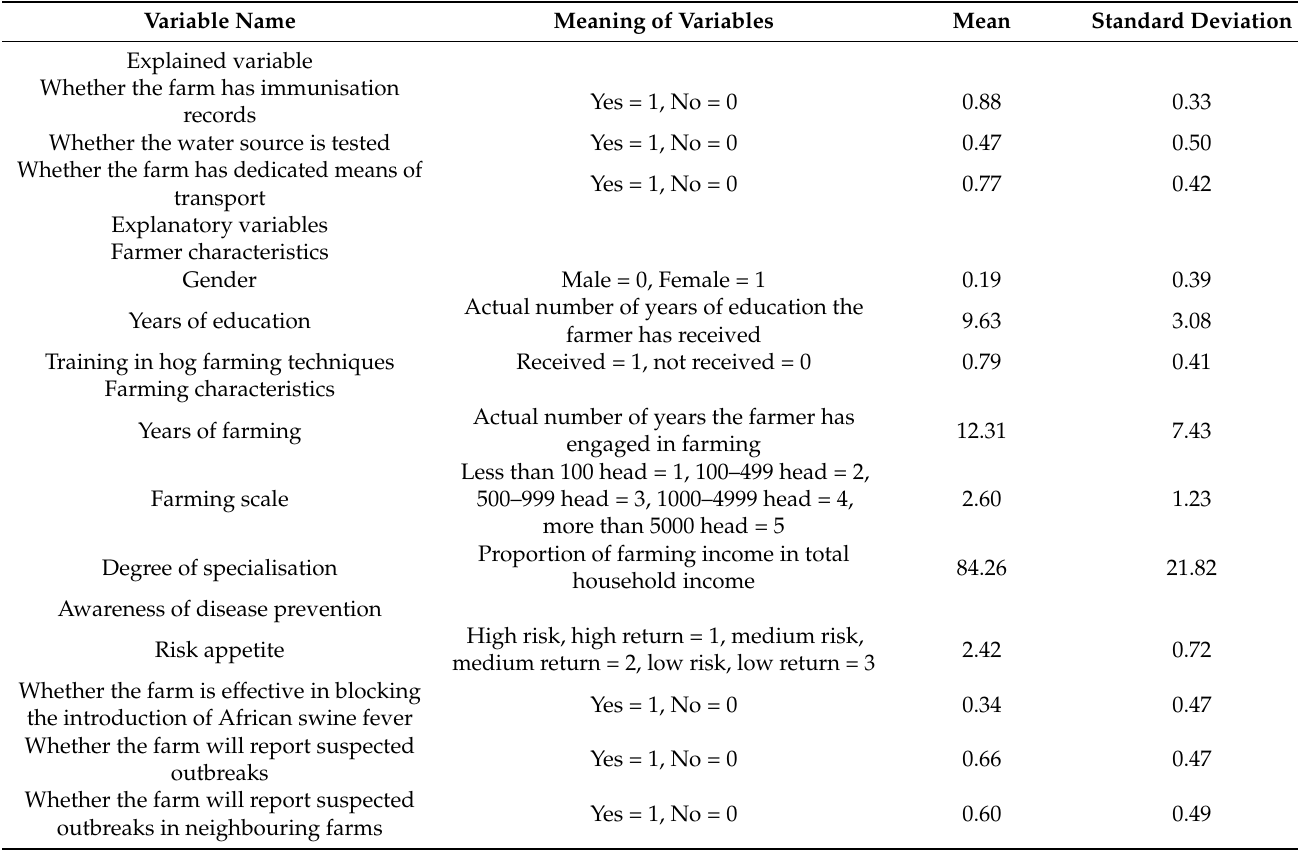
Table 5. Variable definitions and